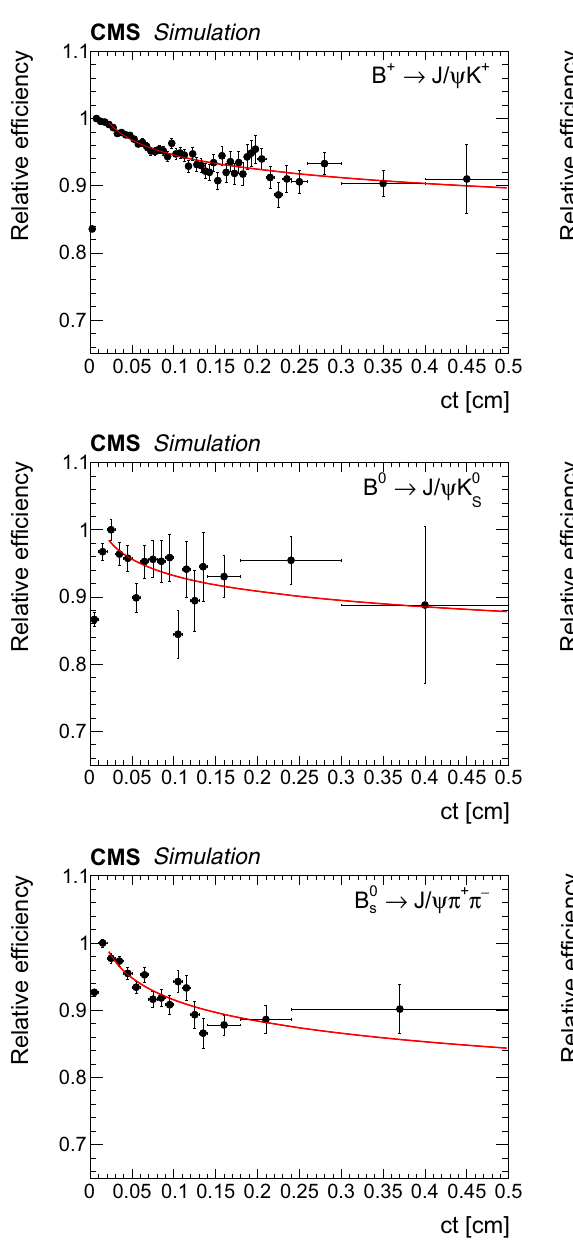
function is used to model the combinatorial background M b . → J /ψπ + π − decay, three additional terms are For the B 0 s added to M b to include specific sources of background. The B 0 → J /ψπ + π − decays are modelled by a Gaussian func- tion, the B + → J /ψ K + decays by a shape taken from sim- ulation, and the B 0 ( d , s ) → J /ψ h − are charged hadron tracks that are not both pions, by a h 2 Gaussian